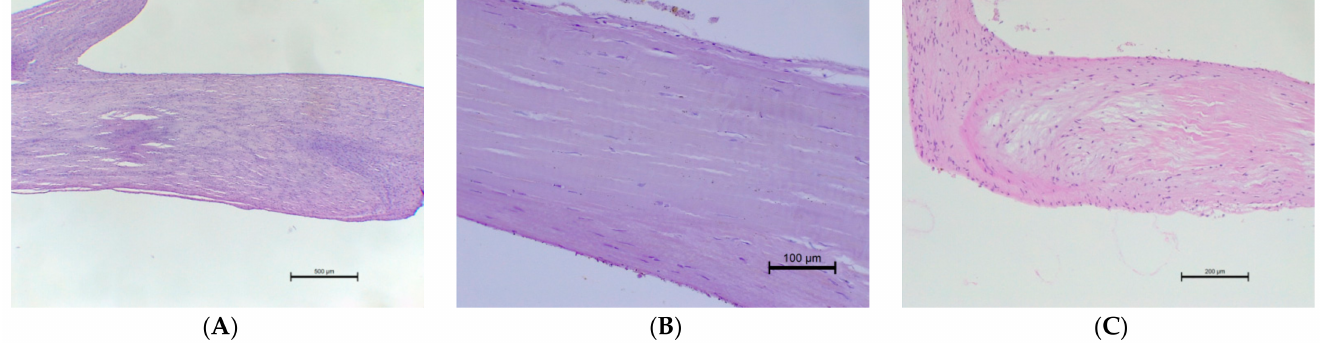
Figure 5. The microscopic examination of Chordae tendineae from normal and diseased mitral valves. ( A ) Normal chorda tendinea from pig; HE stain; magnification 40 × . ( B ) Normal chorda tendinea from a dog; HE stain; magnification 200 × . ( C ) Altered chorda tendinea from dog suffering from mitral valve disease—disarrangement in the filaments is visible; HE stain; magnification 100 × . The left side of each figure is the attachment point to the valve, the right side is that to the papillary